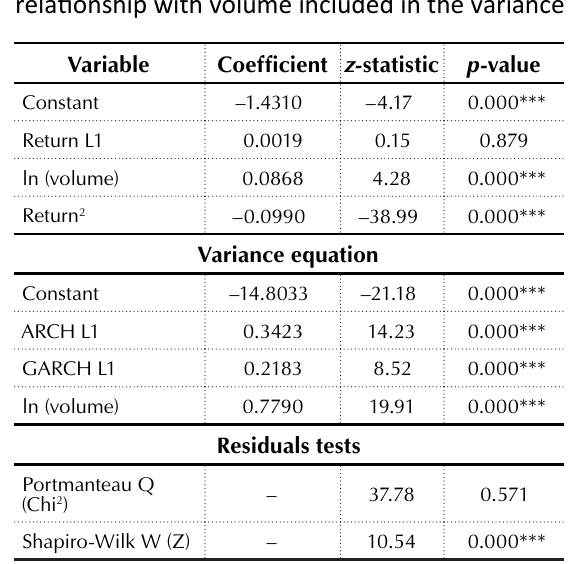
Table 4. GARCH (1,1) of volume, return,